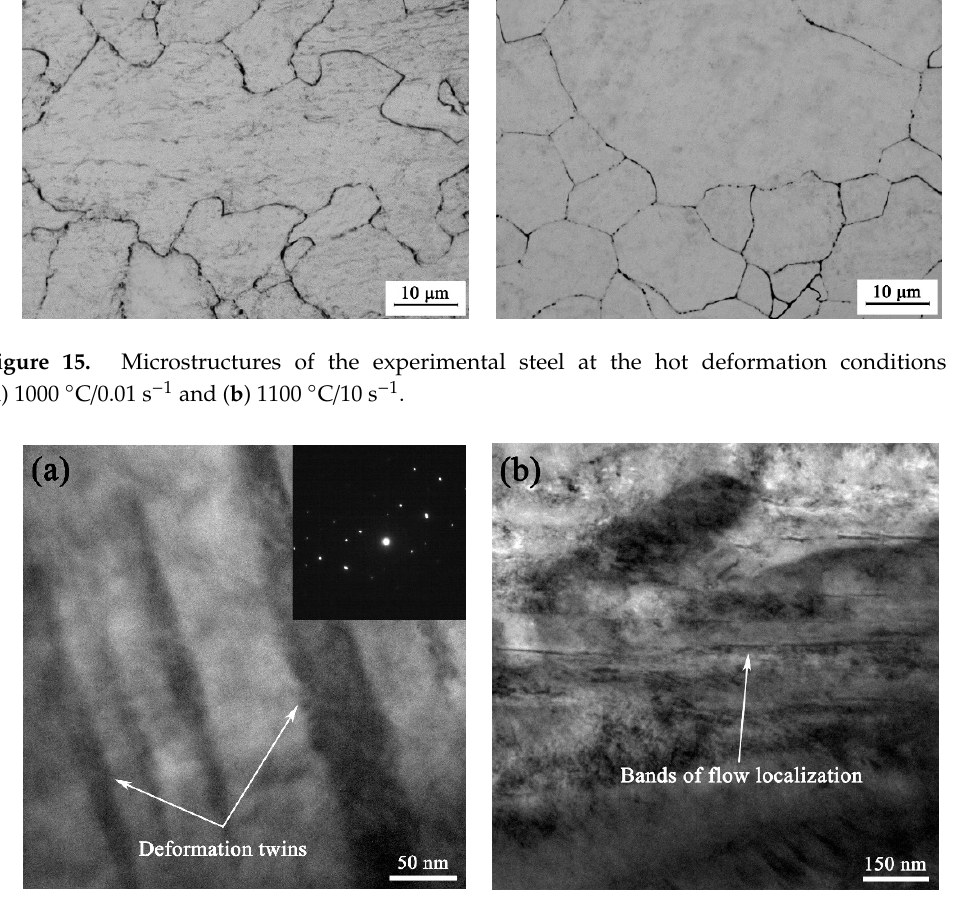
Figure 16. TEM images of the experimental material at the deformation condition of 1000 °C/0.01 s − 1 : ( a ) deformation twins and ( b ) bands of flow localization.